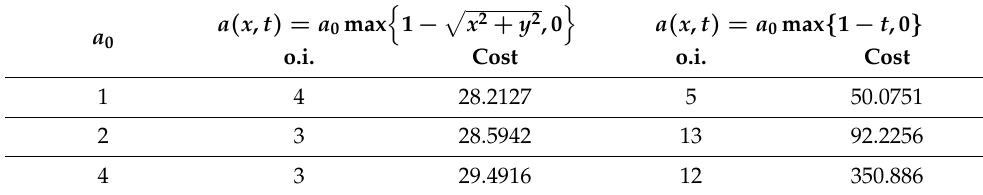
Table 6. Number of outer iterations (o.i.) and values of the cost